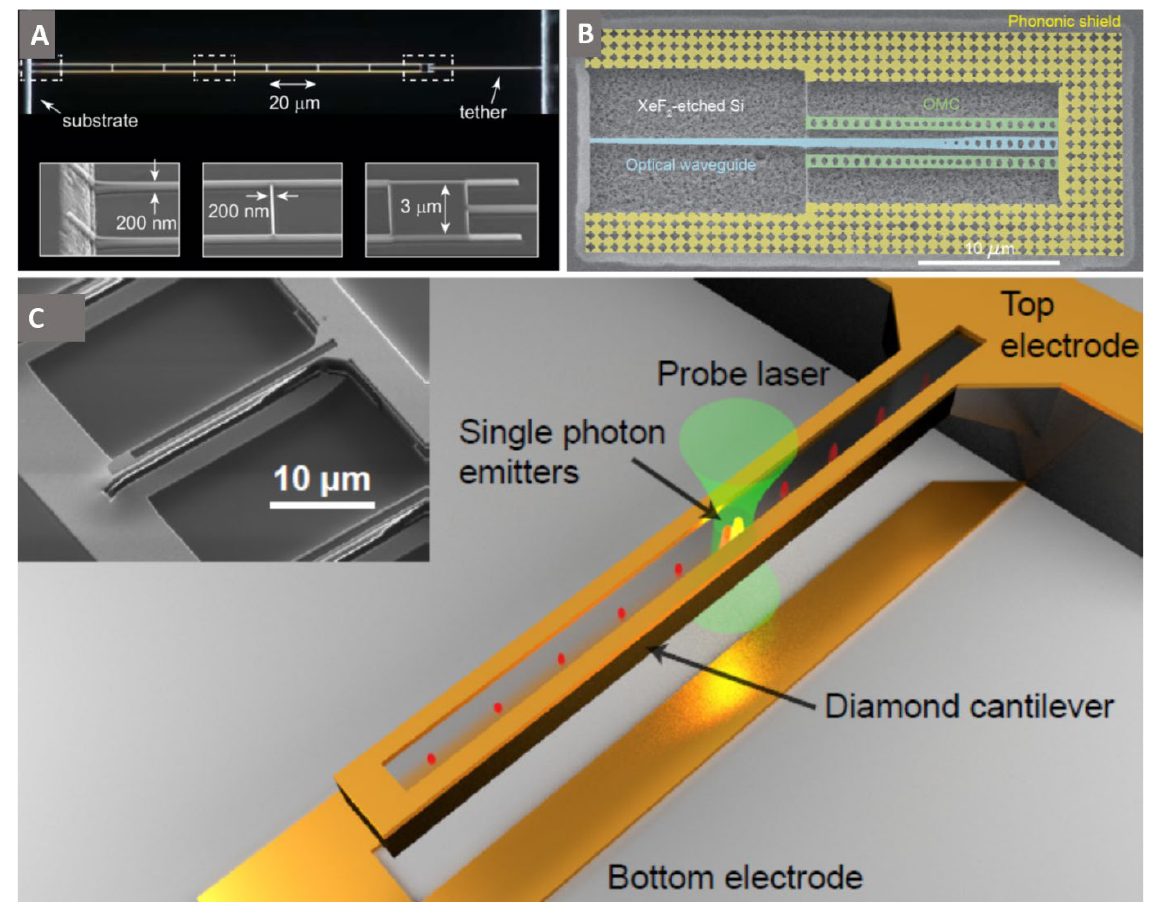
Figure 5. ( A ) Optical micrograph of a single crystal diamond nanoladder cantilever (150 µ m long) realized using a combination of E-beam lithography and dry etching processes. Each nanoladder device consists of two parallel nanowires (200 nm wide) connected via rugs at every 20 µ m distance. The zoomed in view of the base, middle and tip regions of the ladder is shown in the insets. Reprinted (adapted) with permission from Ref. [12]. Copyright (2018) American Chemical Society. ( B ) SEM image of a pair diamond optomechanical crystals on either side of diamond optical waveguide realized using diamond on insulator technique. The optomechanical crystal consists of a rectangular cross-section, single crystal diamond nanobeam with a one-dimensional array of ellipses etched along its length. Image reprinted with permission from Ref. [28] copyright IOP publishing, Reproduced with permission. All rights reserved. ( C ) Schematic representation of a diamond microcantilever realized using a combination of E-beam lithography and angled etching technique followed by electrode definition using e-beam lithography and lift-off process. The color centers (GeV) are precisely implanted (lateral accuracy > 50 nm) using focussed ion beam implantation technique. Application of a bias voltage between the top and bottom electrodes causes strain in the cantilever. Using a probe laser, multiple color centers (GeVs) can be simultaneously optically accessed. SEM image of the diamond microcantilever with dark and light regions representing the diamond and electrodes is shown in the inset. Reprinted with permission from Ref. [79]. Copyright (2018) by the American Physical Society.